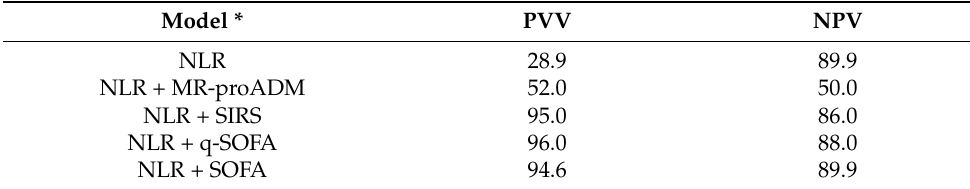
Table 5. Improvement of the prognostic role of NLR with further biomarkers or clinical scores: positive predictive value (PPV) and negative predictive value (NPV) reached by the association of different biomarkers and clinical scores. Model *